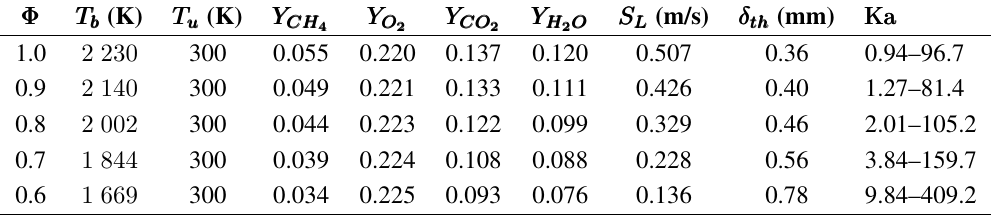
Table 1. Initial flame and flow